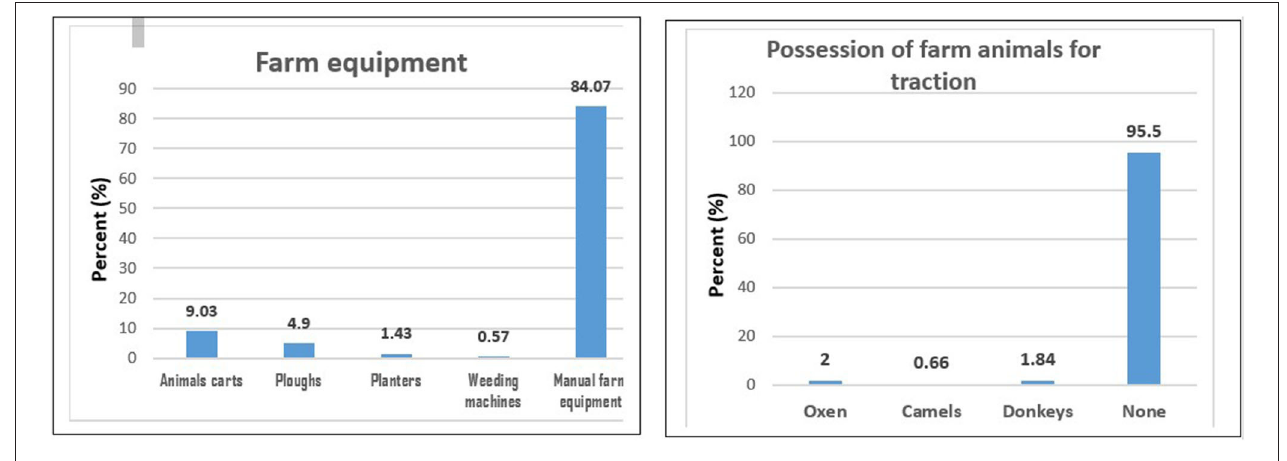
FIGURE 6 | Possession of farm equipment and traction animals.